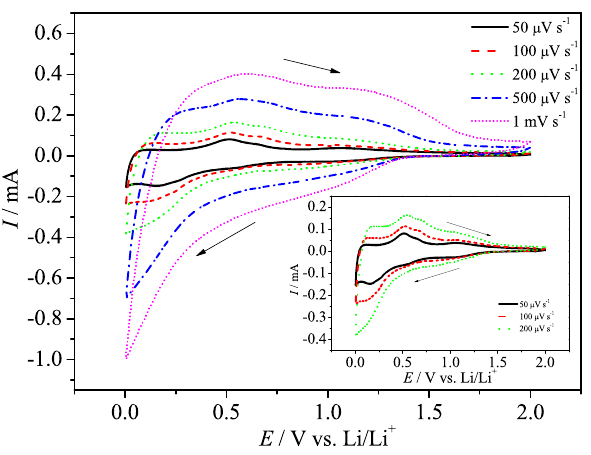
Figure 4. CV curves of SnO x /CHI electrode in LP30 at different sweep rates. Inset: Enlarged CV curves at sweep rates between 10 and 50 µ V s − 1 . The potential range: 0.005–2.0 V versus Li/Li + . The analysis of the charge storage contribution at sweep rates 50 µ V s − 1 , 200 µ V s − 1 , and 1 mV s − 1 , according to Equation (1), is given in Figure